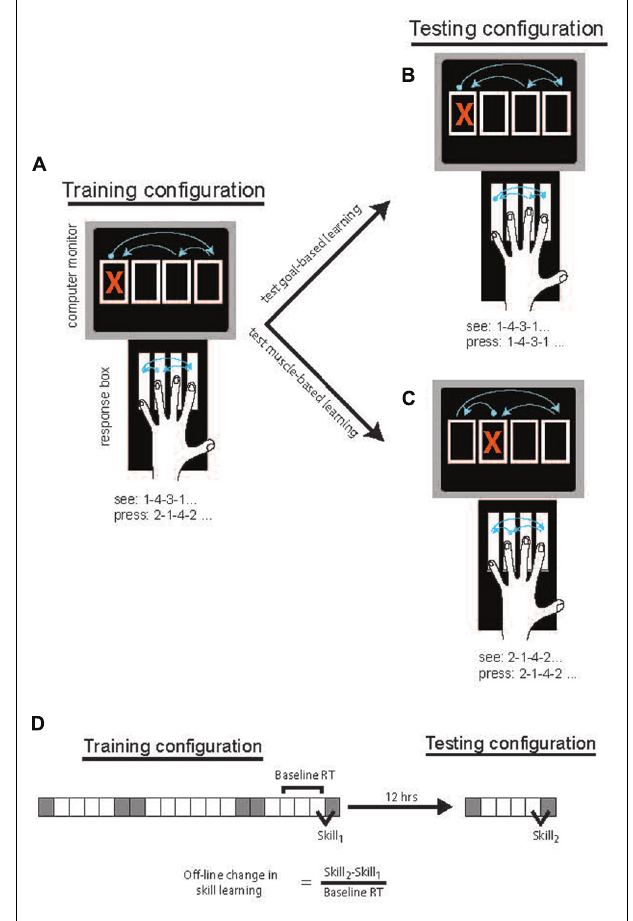
FIGURE 1 |Task design was based onWillingham (1999). In theTraining Phase (A) , participants responded to the location of the cue by pressing the response key one to the right of the spatially cued location (and pressing the far left key when the far right location is cued). Following 12-h either containing overnight sleep or daytime wake, participants performed the Testing Phase in which responses were made to the location directly corresponding to the cue.To probe goal-based learning (B) , half of the participants in each group responded to the same stimulus sequence.To probe muscle-based learning (C) the remaining participants responded to stimuli that were changed such that the movement response sequence was the same as during theTraining Phase.The block design and measure of skill acquisition (D) were based on that used by Cohen etal. (2005). Gray squares = random blocks;White squares = sequence